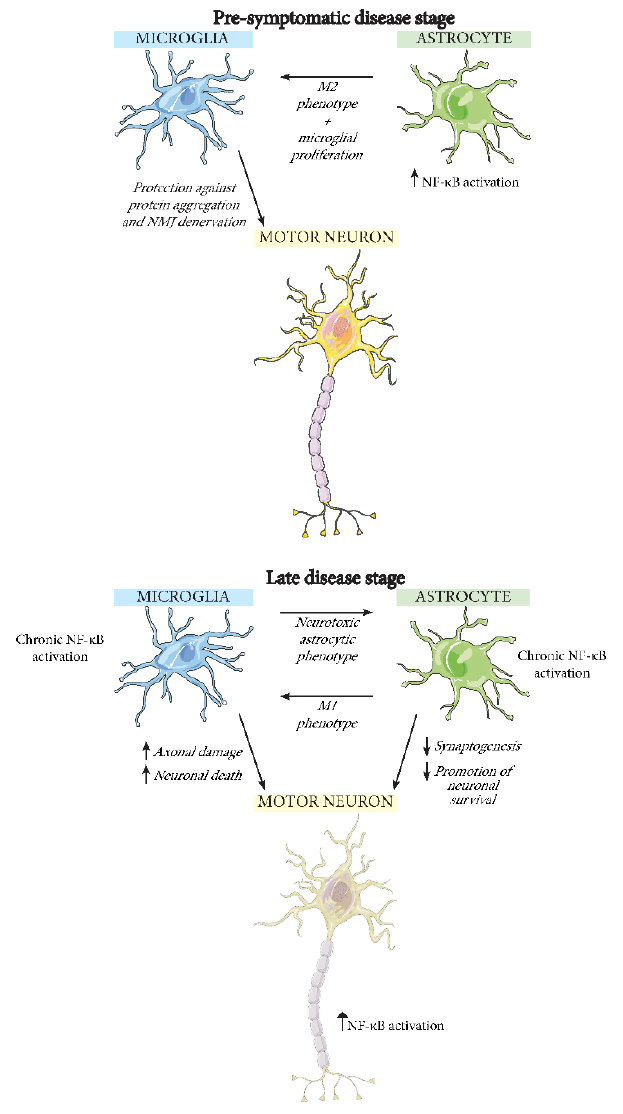
Figure 3. Illustration of the possible interactions between microglia, astrocytes, and neurons, during early and late stage ALS. The NF- κ B pathway is activated in both astrocytes and microglia in ALS, but its effects differ between the stages of the disease. Pre-symptomatically, astrocytes with activated NF- κ B promote neuroprotective M2-type microglial proliferation, while at a later stage a neurotoxic M1-type microglial phenotype is induced. Subsequently, M1 microglia cause axonal damage and promote motor neuron death. In addition, M1 microglia induce a neurotoxic astrocytic phenotype, leading astrocytes to decrease their synaptogenesis and promotion of neuronal survival.